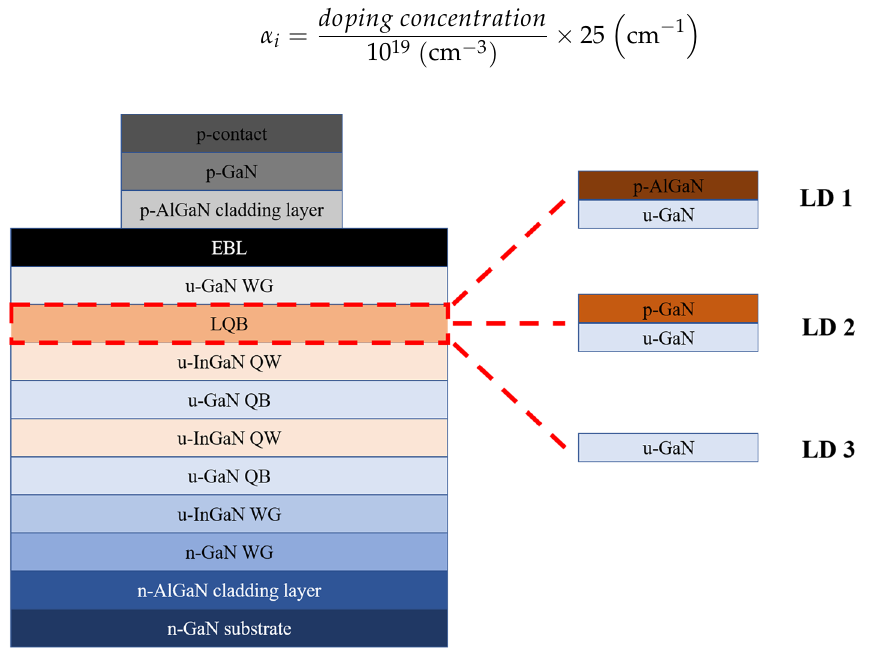
Figure 2. The schematic structure of LDs used in the simulation. Table 1. Simulation parameters of each layer of LD1.